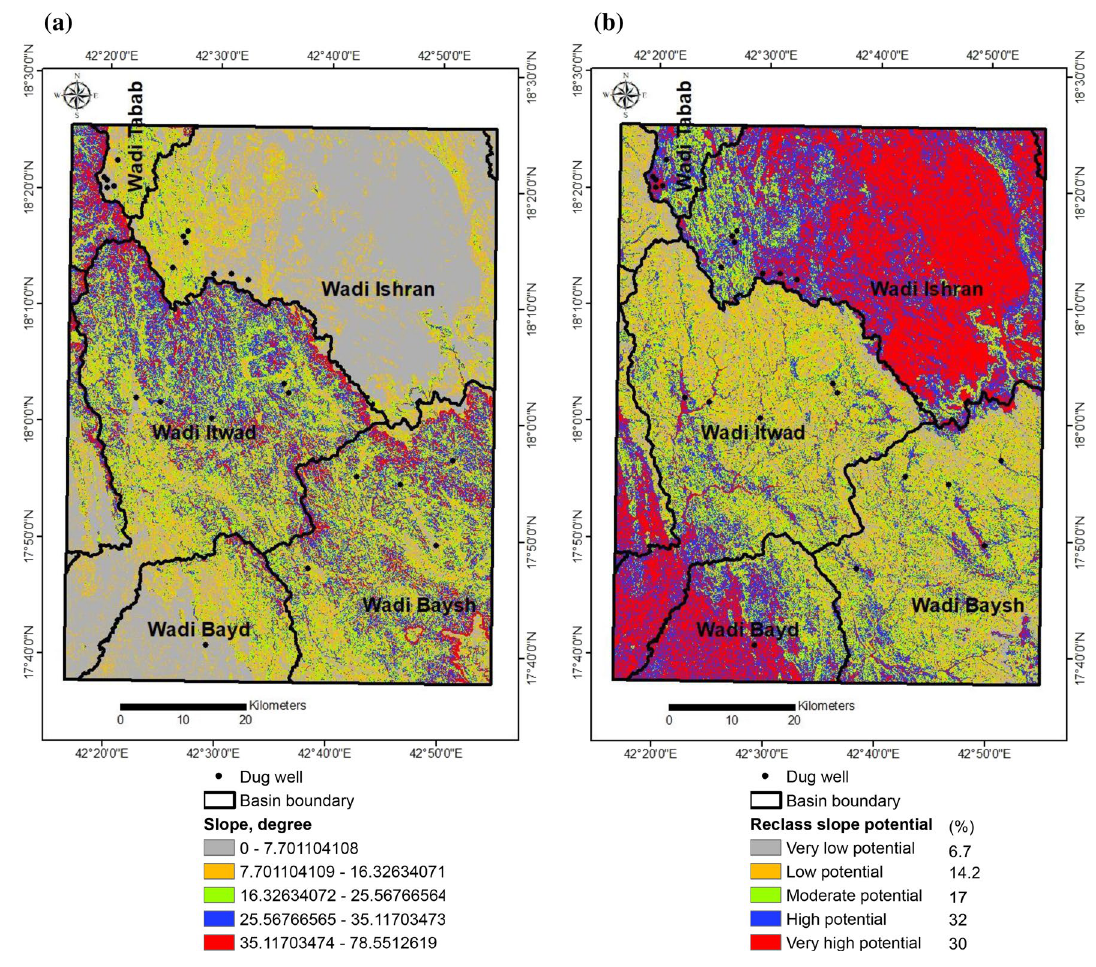
Fig. 6 a Slope and b reclassified slope of the study